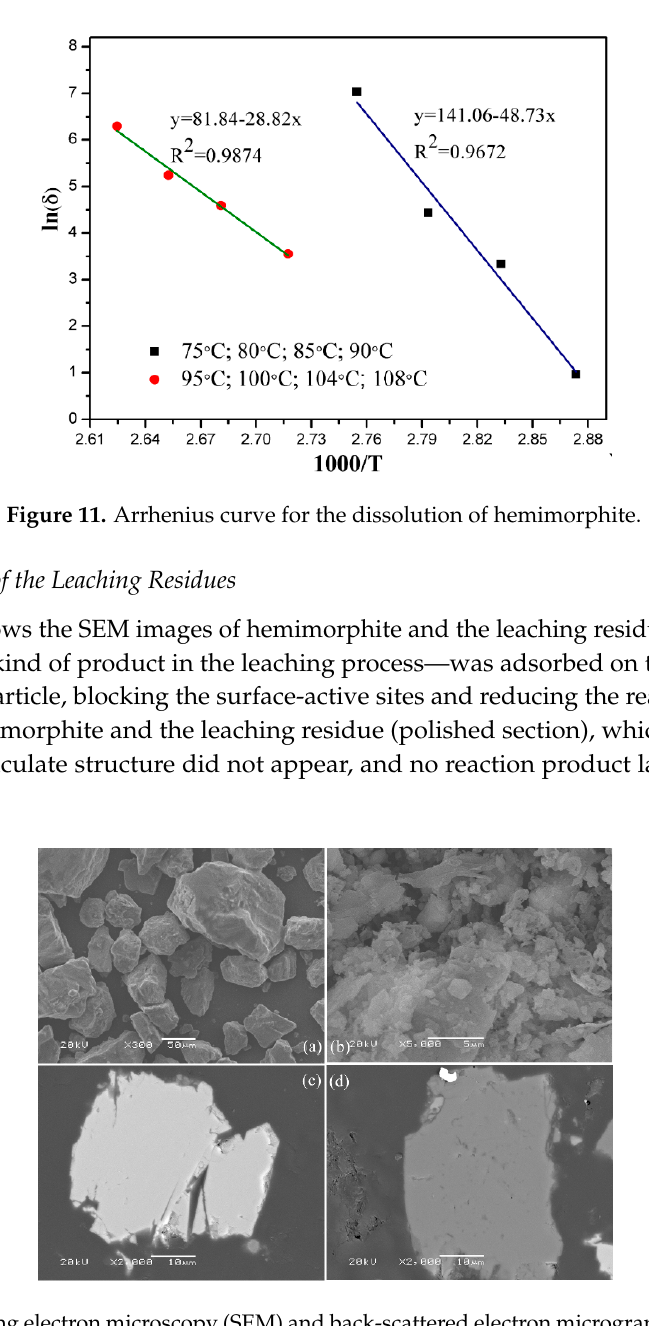
Figure 12. SEM and back ‐ scattered electron micrograph (BEM, polished section) of hemimorphite and the leaching residue. ( a ) material, ( b ) temperature, 100 °C; solid/liquid ratio, 5 g/L; stirring speed, 350 rpm, ( c ) material, ( d ) temperature, 100 °C; solid/liquid ratio, 5 g/L; stirring speed, 350 rpm; zinc